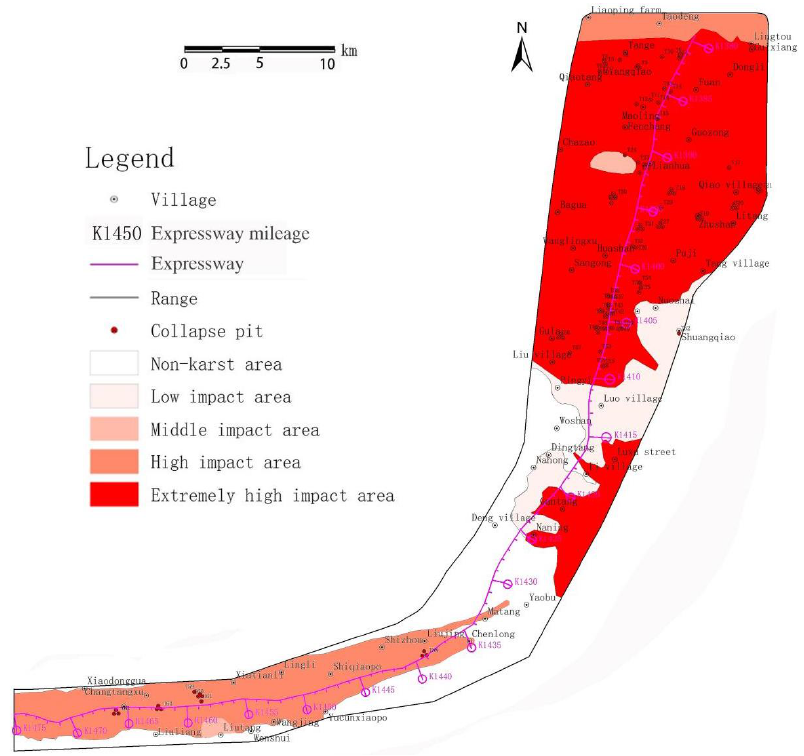
Figure 9. Zoning map of influence degree of karst landform on karst collapse.